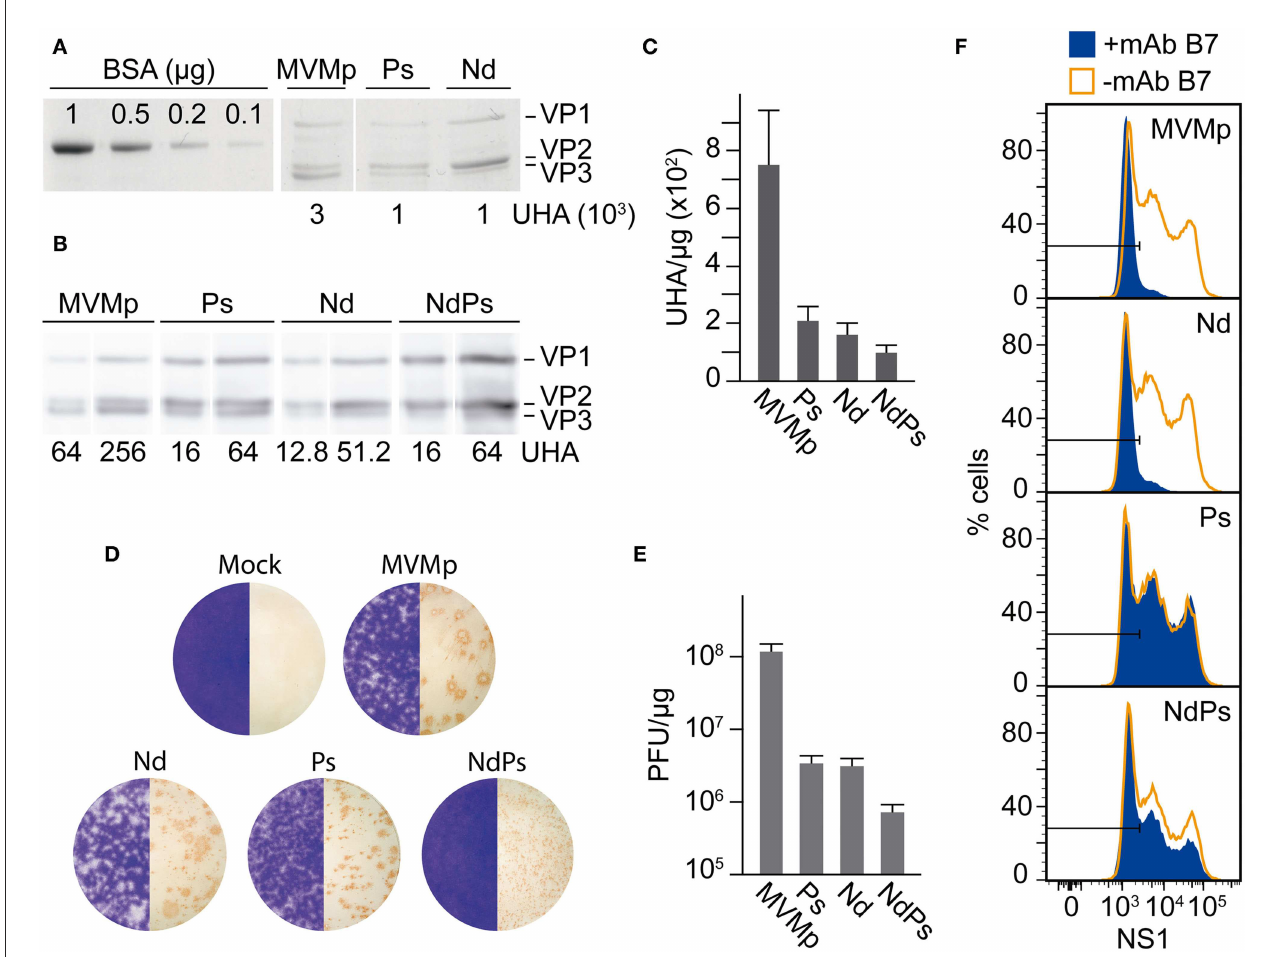
FIGURE2 Specific infectivity of MVM-VEbp chimeric virions. (A) Quantitative analysis of the hemagglutinating capacity of gradient-purified DNA-filled MVMp and MVM-VEbp chimeric virions determined by (A) SDS-PAGE Coomassie staining of VPs from the indicated UHA and (B) by Western blot analysis of the virion samples developed with the anti-VPs antibody. BSA (micrograms) was used as mass loading control. The amount of HAUs loaded for each of the viruses is indicated. (C) Relative hemagglutination activity obtained from the analysis outlined in (A, B) . Values were scored from at least three assays performed with two independent virion preparations. (D) Plaque morphology. The figure illustrates the size and lytic character of the plaques formed in NB324K cells by the indicated wt and chimeric viruses. Left half, crystal violet staining using 10 − 4 dilutions of the three chimeras and 10 − 6 of MVMp; right half, anti-VPs antibody staining method (see Materials and Methods) using 10 − 4 dilutions of NdPs, 10 − 5 of Nd and Ps and 10 − 7 of MVMp. (E) Specific infectivity outlined as the ratio of PFUs (developed by the anti-VPs antibody staining method in NB324K monolayers) with respect to the mass amount of the inoculated purified virus particles. Values are the means with standard errors from at least three independent determinations. (F) Chimeric MVM-VEbp virions evade antibody neutralization. Shown are infected NB324K cultures (MOI 10 using the PFU assay developed by the anti-VPs staining method), incubated